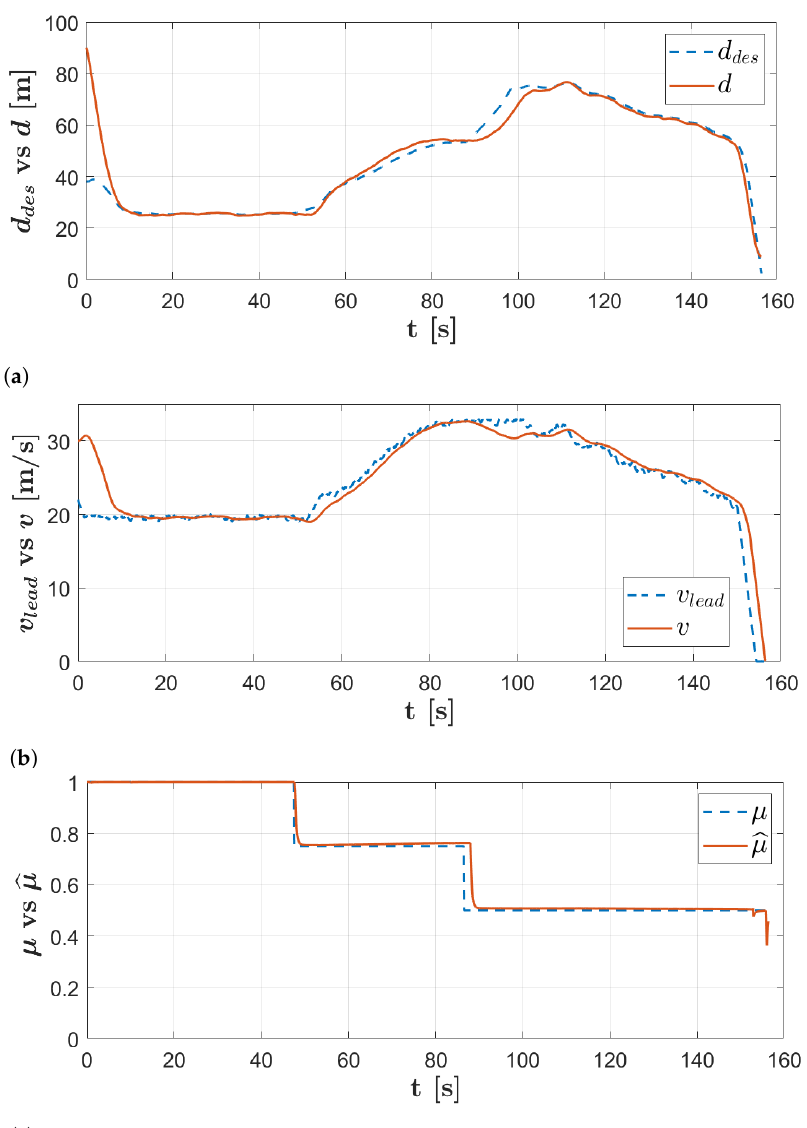
Figure 10. Road-Grip aware Driving Functionalities in case of varying µ : vehicle-following and hard emergency braking. ( a ) Time-history of the current distance gap, d , and of the desired one, d des . ( b ) Time-history of the ego velocity v and leader velocity v lead . ( c ) On-board road-grip estimate, µ ( t ) vs. (cid:98) µ